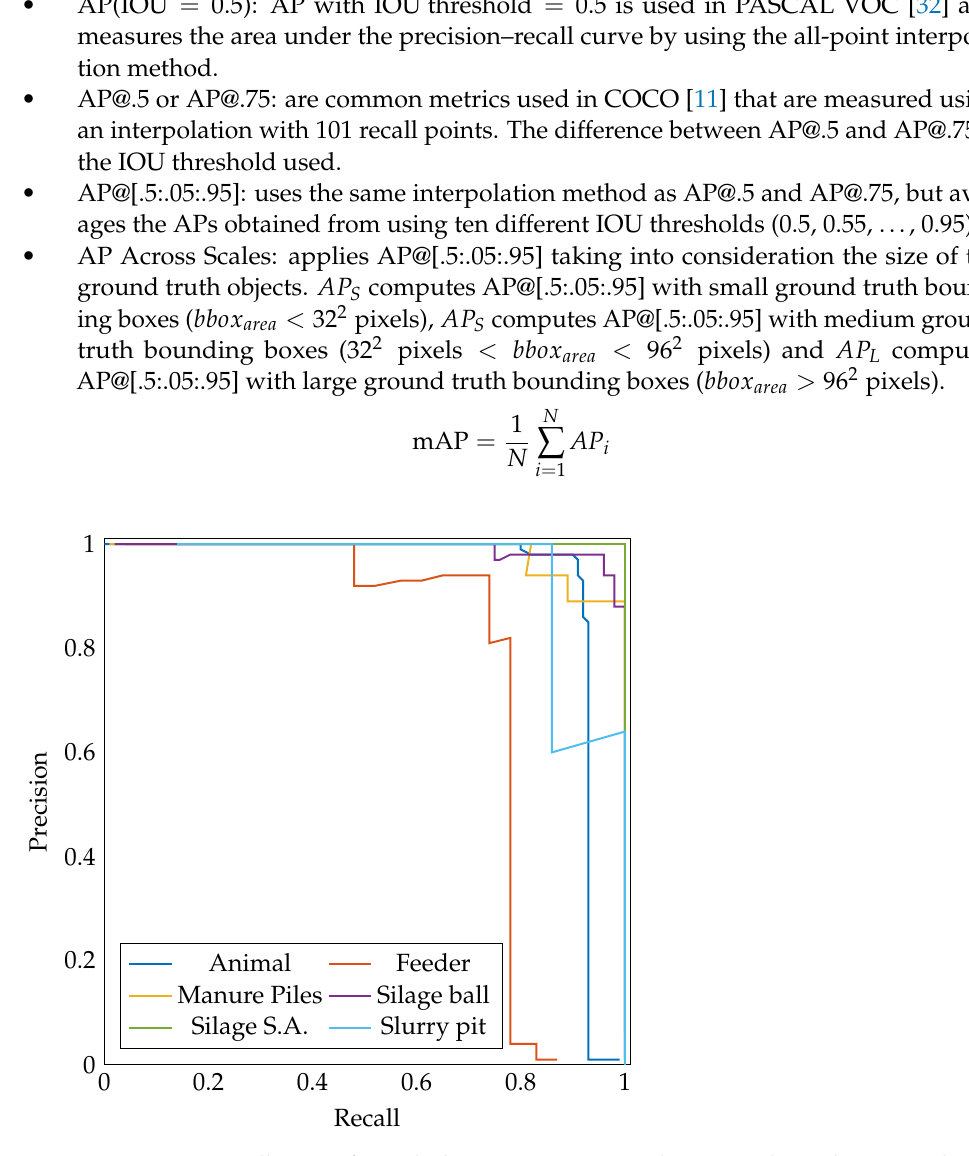
Figure 4. Precision–recall curves for each class using YOLOv5. The area under each curve is the AP of each